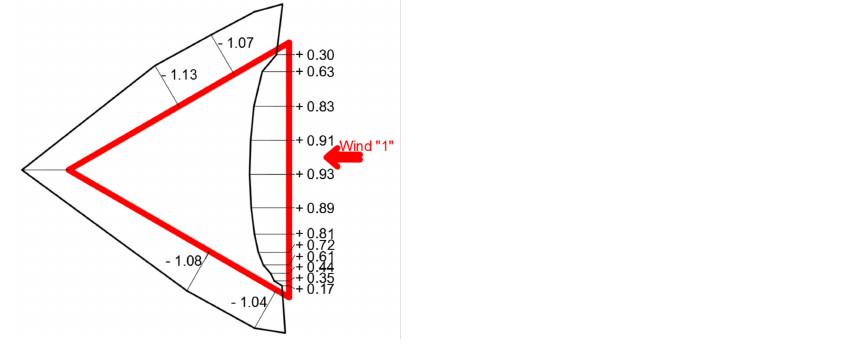
Figure 5. External pressure coefficient Cp [ − ] obtained experimentally for wind flow direction 1.